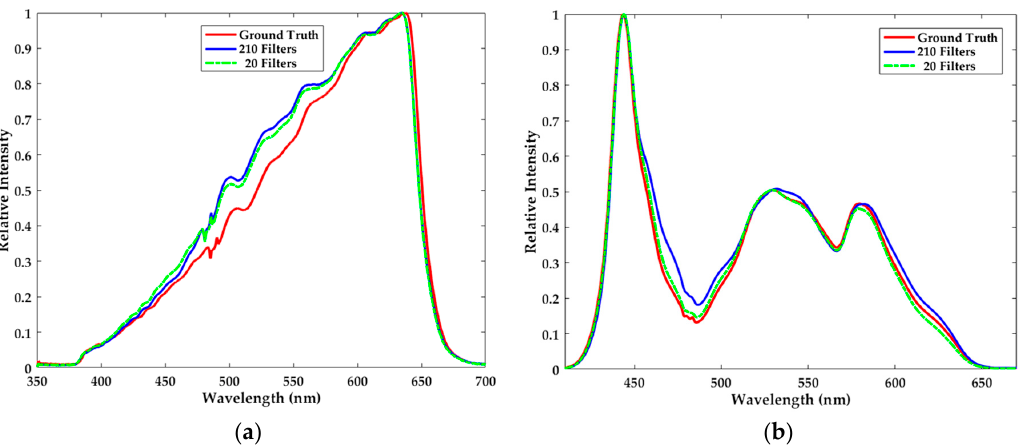
Figure 8. The effect of the number of filters on the reconstruction quality of ( a ) the halogen lamp and ( b ) LED.